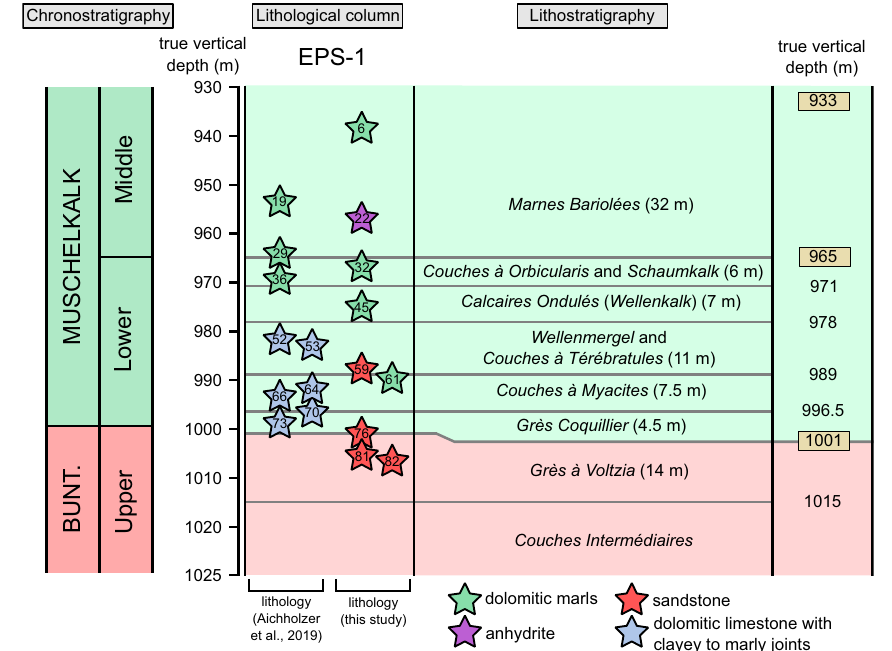
Fig. 2 Chronostratigraphic and lithological columns showing the names, thicknesses, and depths (true vertical depth) of the formations within the Muschelkalk and the top of the Buntsandstein for exploration well EPS-1 (Soultz-sous-Forêts). The approximate depths of the sampled core, fifteen depths in total, are indicated by the stars. The number within the star corresponds to the box number from which the sample was taken, and the colour of the star reflects the lithology (see key at the bottom of the figure). The lithology was either determined using the mineral contents determined using X-ray powder diffraction (this study, see Table 1) or was taken from Aichholzer et al.